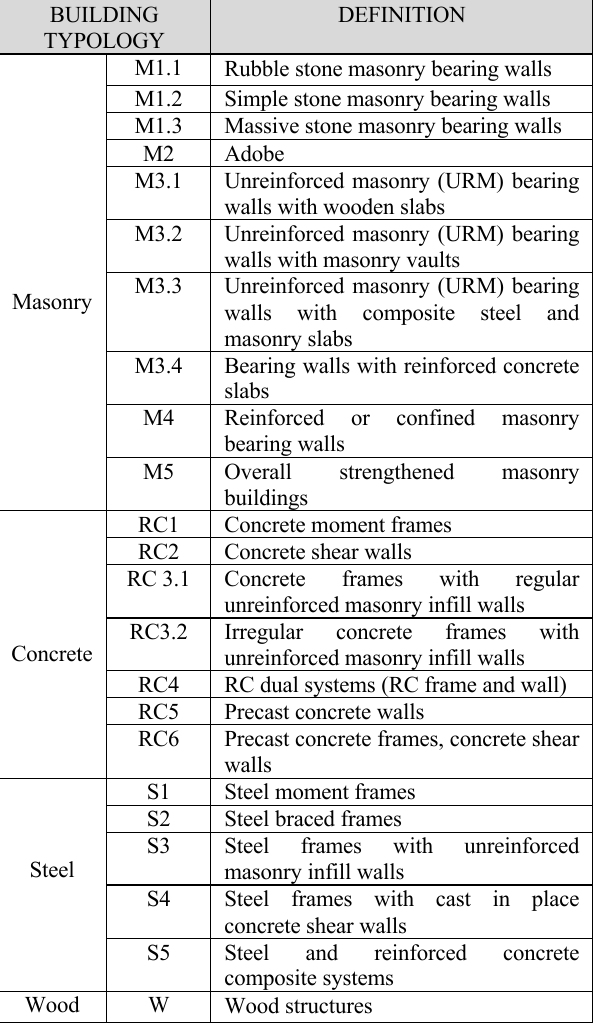
Table 1. Building Typology Matrix proposed by Risk-UE (Milutinovic and Trendafiloski 2003).